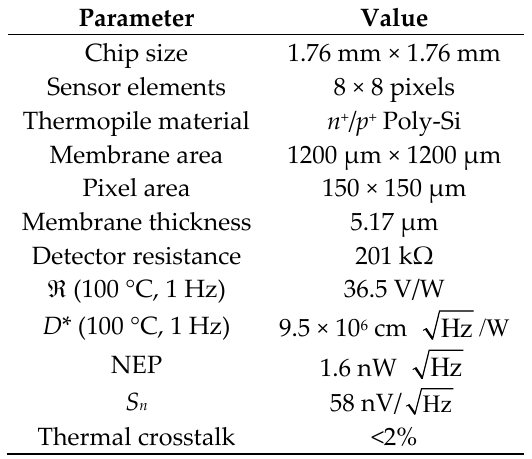
Table 1. Characteristics of the 8 × 8 pixel thermopile